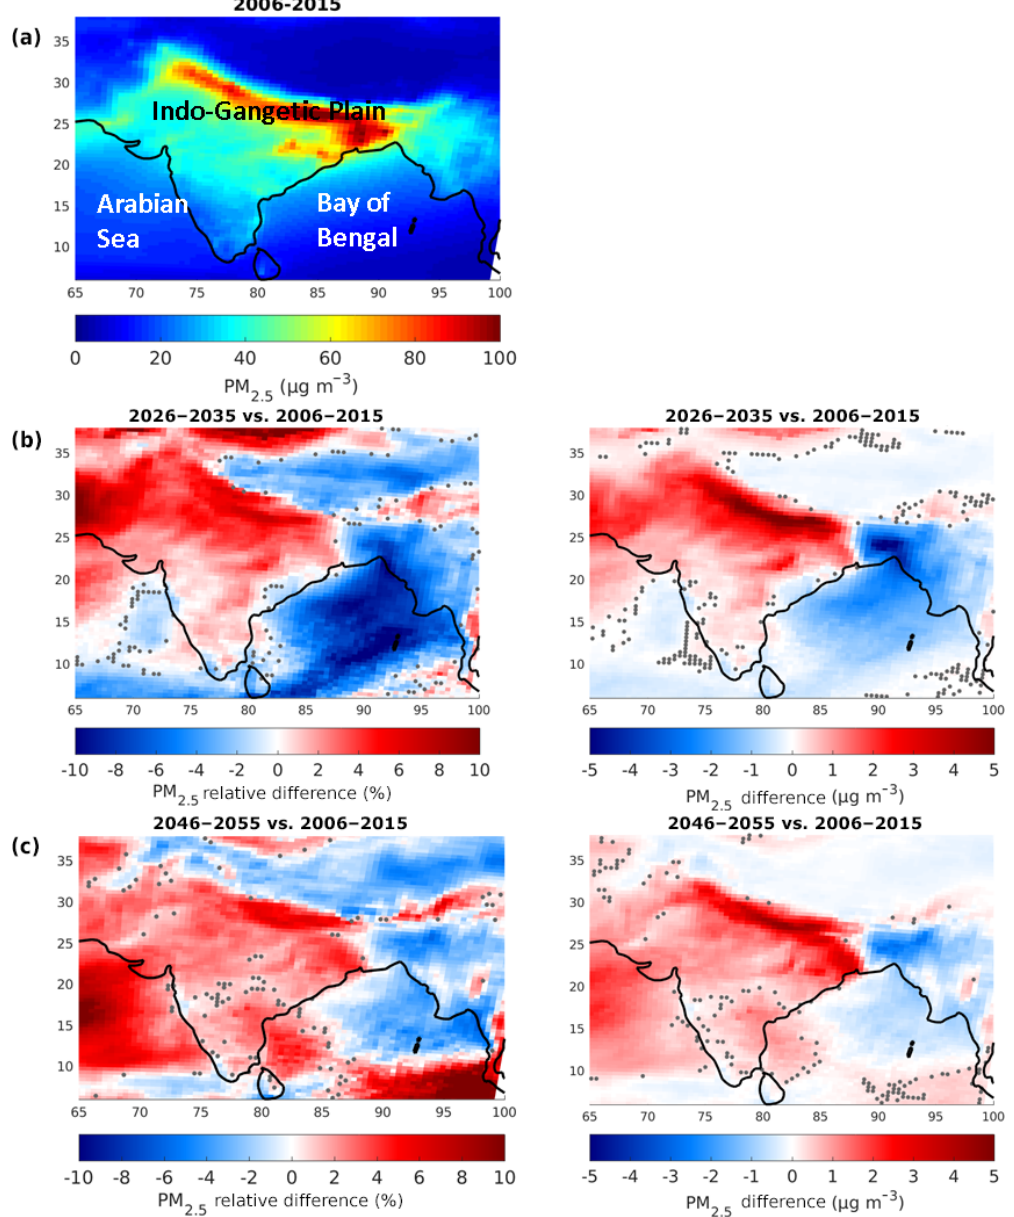
Figure 9. (a) Distribution of surface PM 2 . 5 concentrations (in µgm − 3 ) for the reference scenario. Distribution of the relative difference and absolute difference in surface PM 2 . 5 concentrations between the reference scenario and the FC2030 scenario (b) and the FC2050 scenario (c) . The relative differences are calculated as ([FC – reference] / reference) × 100%, and the absolute differences as [FC – reference]. Grey dots mark grid points that do not satisfy the 95% level of